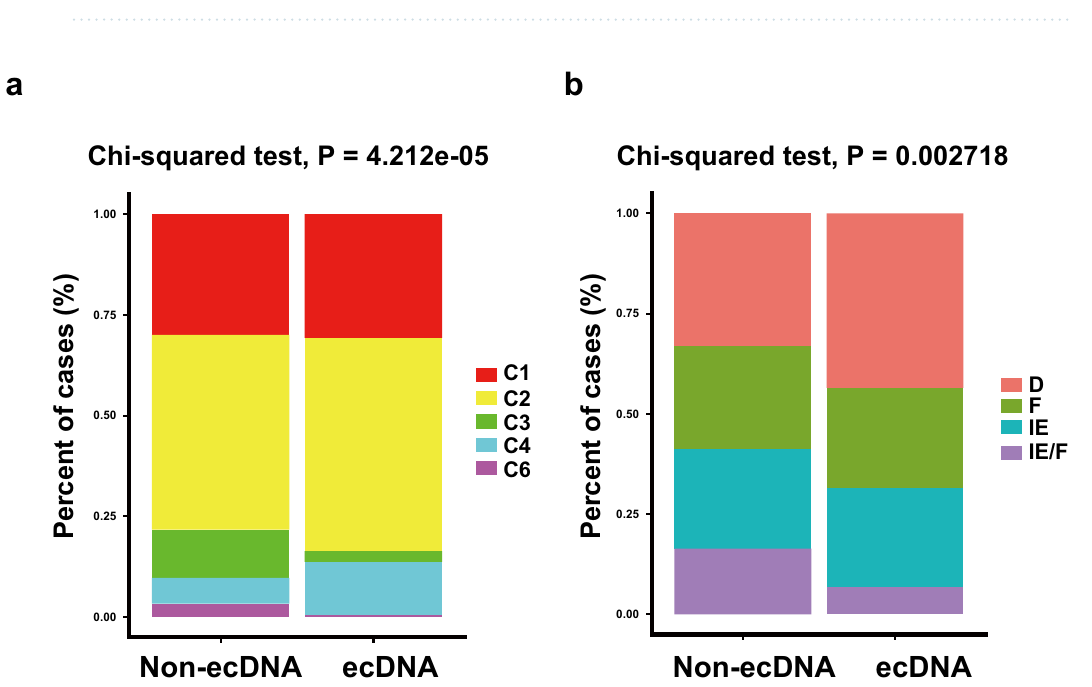
Figure 2. ecDNA and the infiltration of different types of immune cells. ( a ) Comparisons of the compositions of different types of immune cells between tumors with ecDNA and without ecDNA. The immune cell compositions have been quantified by five different methods, including Cibersort, Xcell, Timer, MCPcounter and Quantiseq. Wilcoxon test P values are shown. ns: P > 0.05, *: P ≤ 0.05, **: P ≤ 0.01, ***: P ≤ 0.001, ****: P ≤ 0.0001. ( b ) Comparison of immune cell infiltration levels quantified by five different methods between ecDNA and non-ecDNA samples in different cancer types. Heatmap color indicates ratio of the median infiltration level for specific immune cell and specific cancer type between ecDNA and non-ecDNA samples. TCGA cancer type acronyms: STAD (stomach adenocarcinoma), SKCM (skin cutaneous melanoma), HNSC (head and neck squamous cell carcinoma), LUAD (lung adenocarcinoma), BLCA (bladder urothelial carcinoma), BRCA (breast invasive carcinoma), ESCA (esophageal